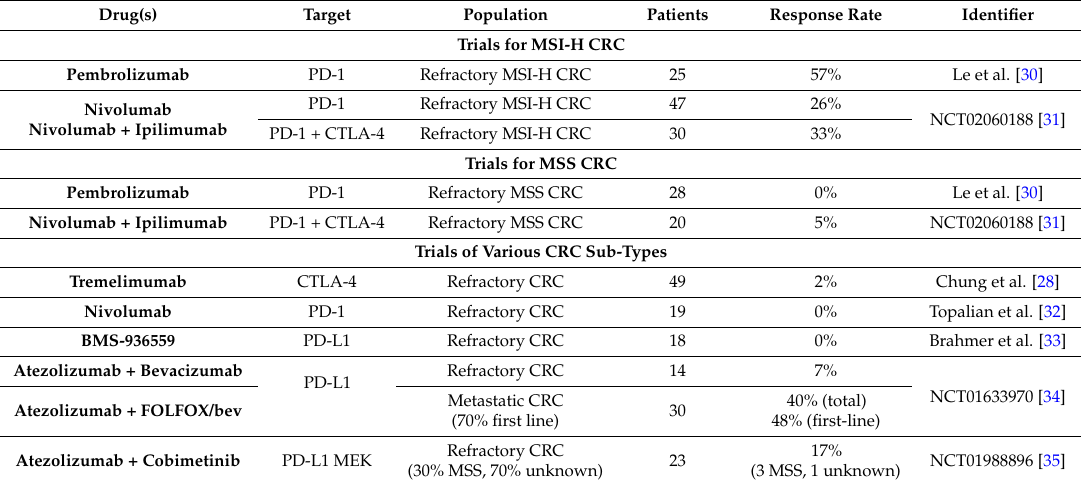
Table 1. Key immunotherapy trials in metastatic colorectal cancer